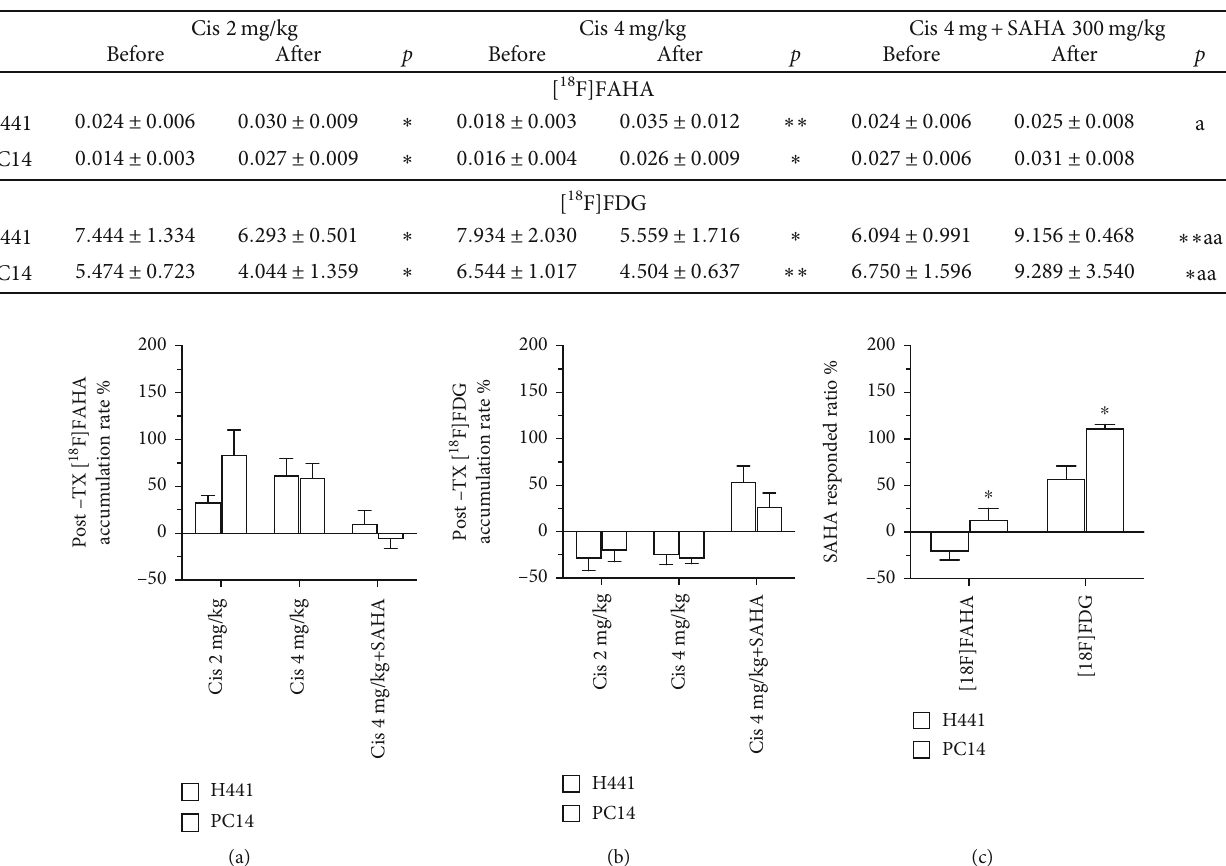
Table 1: Comparison of [ 18 F]FAHA Ki values or [ 18 F] FDG %ID/g accumulation in xenograft tumors before and after drug administration. Data are mean ± SEM . Di ff erent superscript letters indicate signi fi cant di ff erences ( ∗ p < 0 : 05 , ∗∗ p < 0 : 005 compared to the Ki values before drug administration; a p < 0 : 05 , aa p < 0 : 005 Group C vs. Group B).